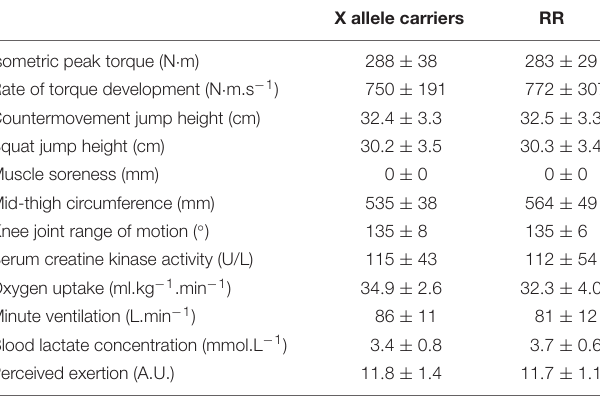
TABLE 2 | The baseline values for all the dependent